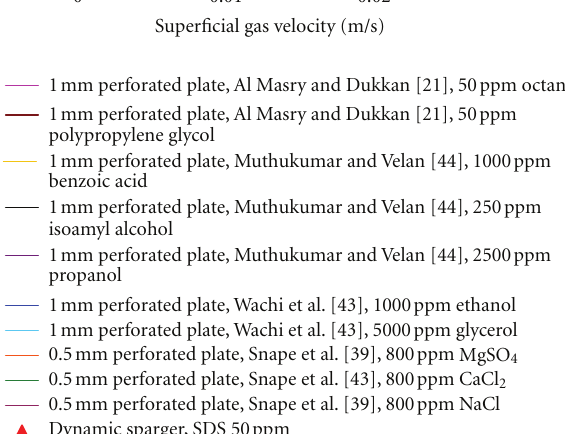
Figure 11: E ff ect of sparger type and contaminants on gas holdup in the